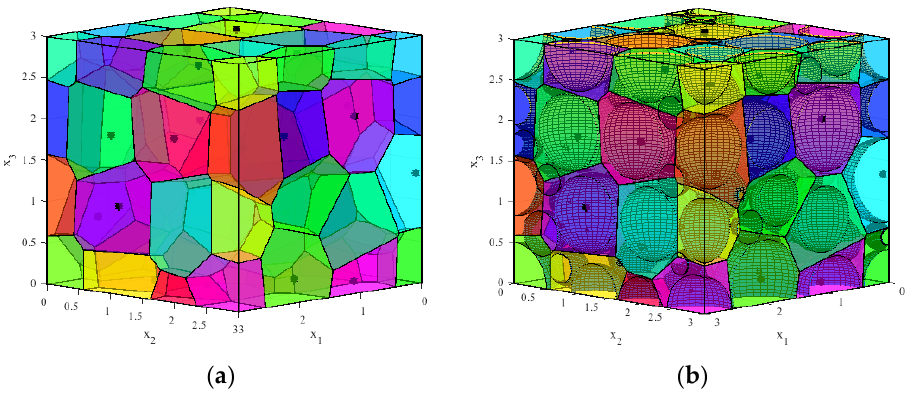
Figure 1. Operation in MATLAB: ( a ) Voronoi tessellation; ( b ) Spheres random packing.